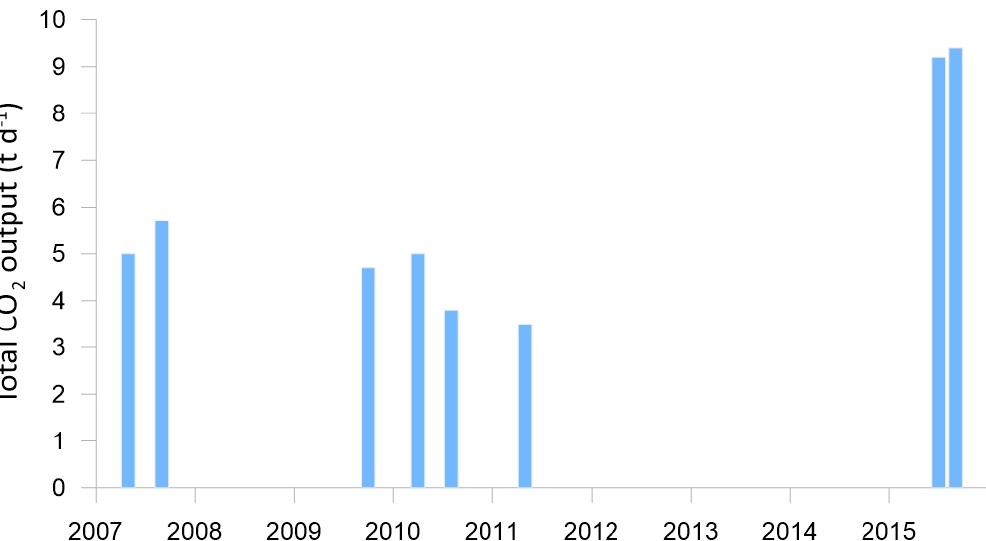
Figure 9. Total output of soil CO 2 (t d − 1 ) from the Baia di Levante area in the period 2007–15 (2011–15 this study; previous data from literature [9,31]).